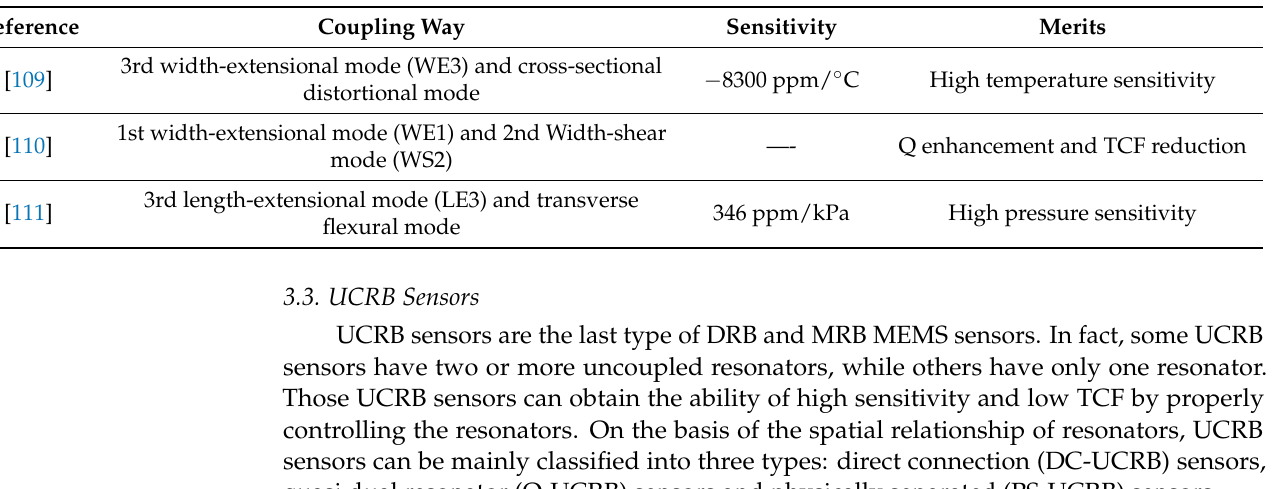
Figure 17. Mode shapes of ( a ) pressure insensitive extensional mode; ( b ) pressure sensitive flexural mode. Reproduced with permission from [111]. Copyright © 2014, IEEE. Table 7. Comparisons of properties of WCRB